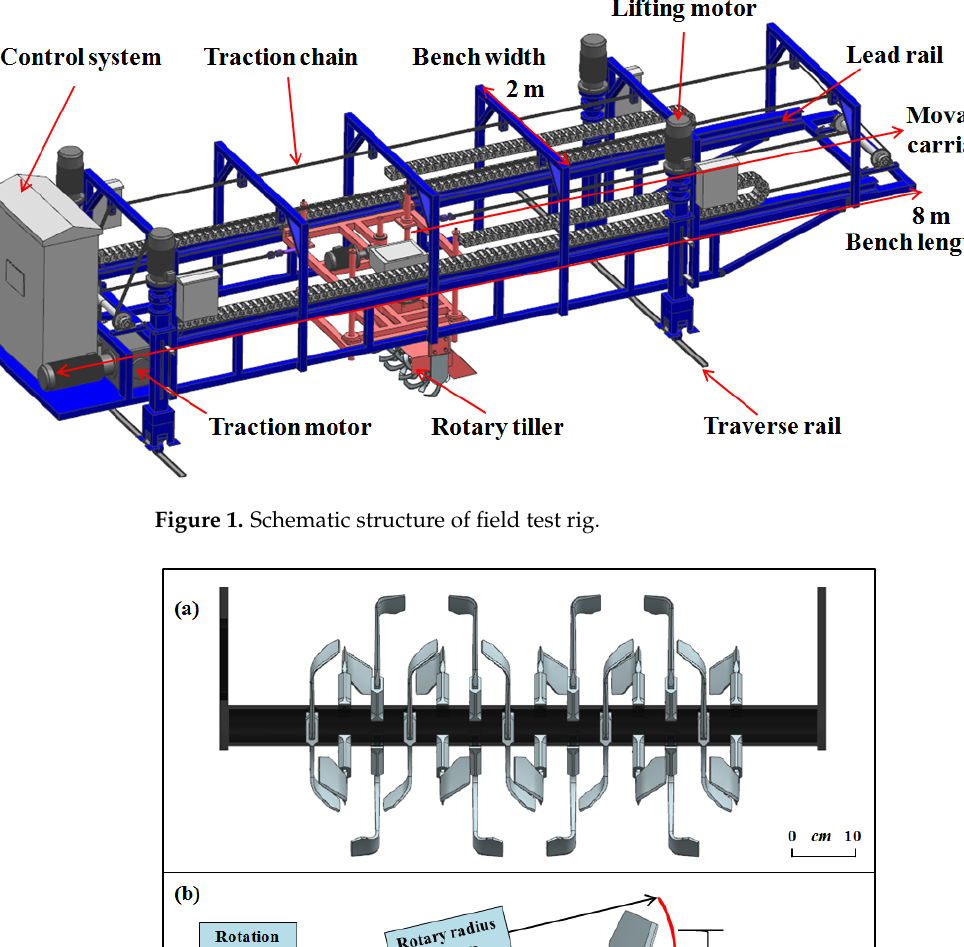
Figure 1. Schematic structure of field test rig.